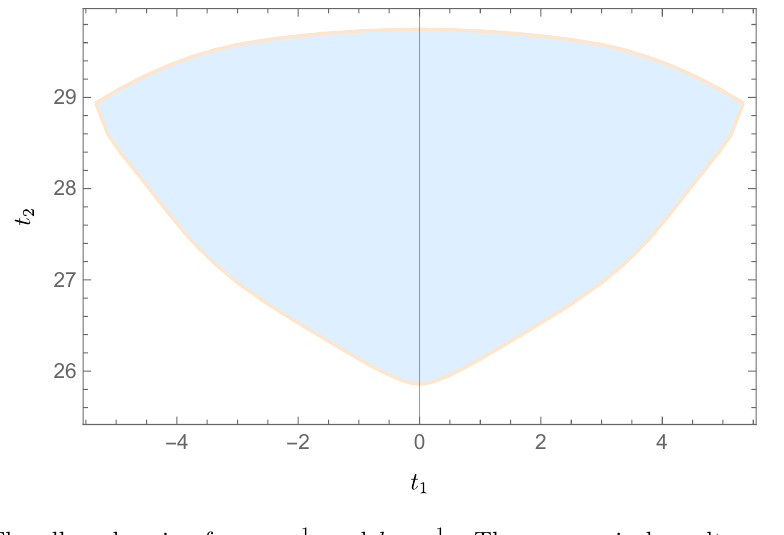
Figure 11 . The allowed region for g = 1 Λ = 8